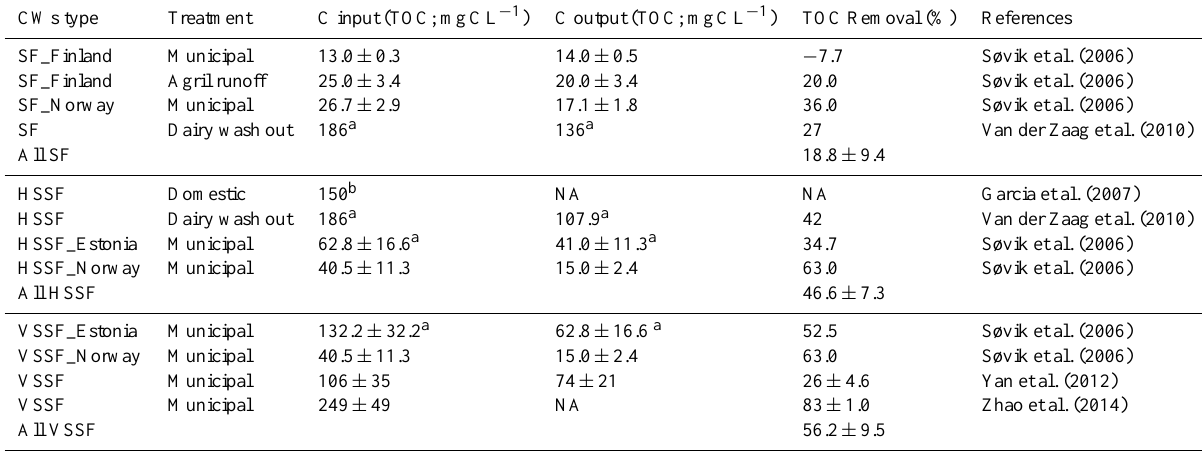
Table 2. Total organic C (TOC) removal (%) in various CWs treating wastewater; average standard error ( ± SE) is presented for TOC removal; NA – data not